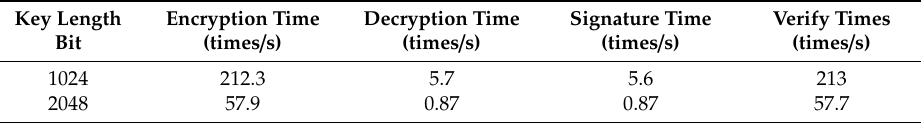
Table 3. RSA computing time with different key lengths.